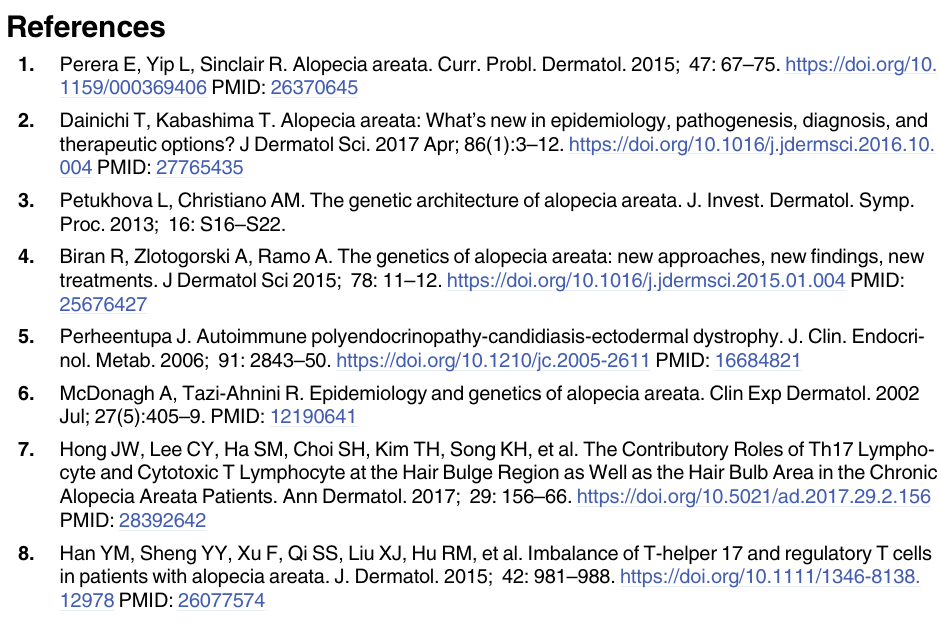
S7 Fig. Cluster density and passing filter box plot quality control. The lanes (1–8) in flow cell are represented on the X-axis. The cluster density is represented on the Y-axis. The sam- ples were loaded on lane 1 (23 samples). Cluster density in the blue box and %PF in the green box and the median shown by a red line. The cluster density and %PF boxes are